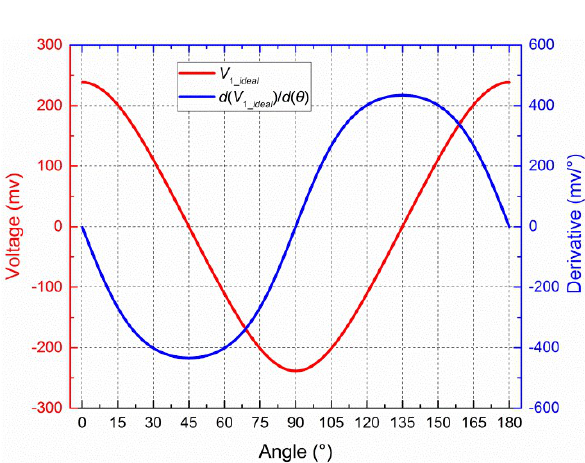
Figure 13. V 1_ ideal and its derivative when d = 0.5.